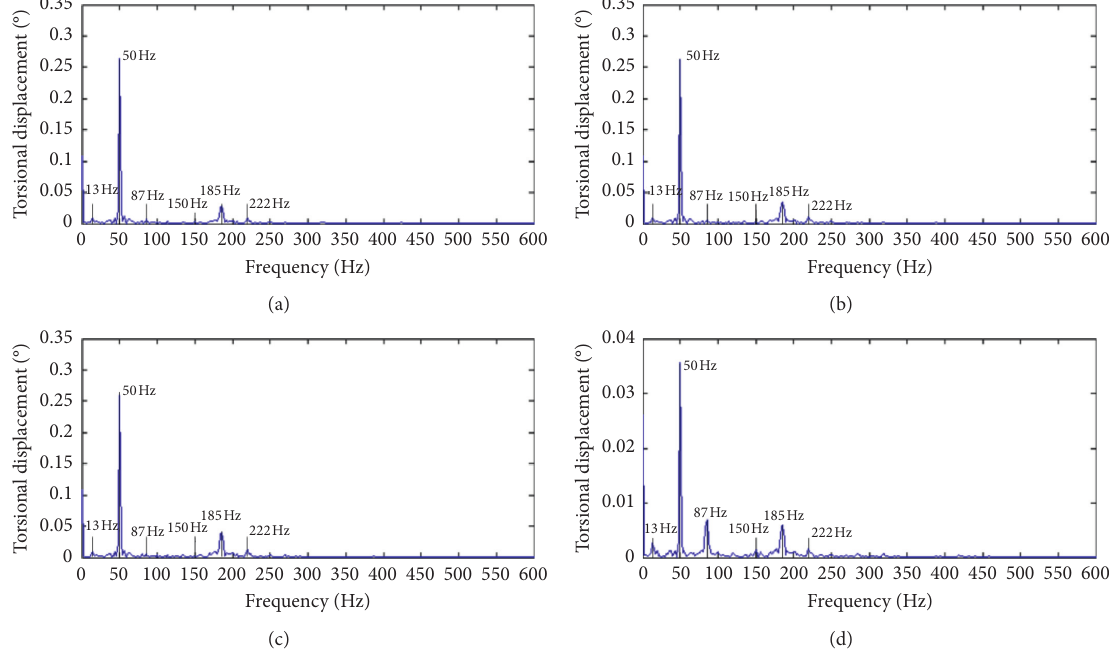
Figure 6: The Fourier spectrum of torsional responses: (a) output shaft of transmission; (b) output end of the drive shaft system; (c) torsional displacement of the pinion along the axis x ; (d) torsional displacement of the gear along the axis y